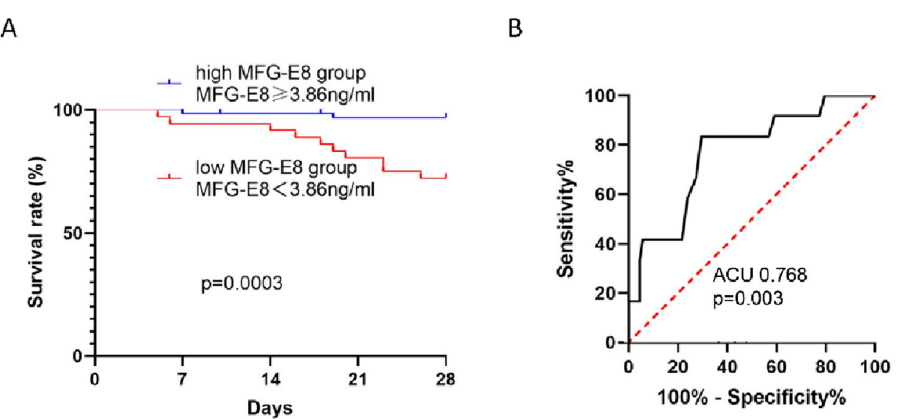
Figure 2. The ROC curves of predicting for 28-day survival and Kaplan–Meier estimator analysis of MFG-E8 for 28 day survival. ( A ) Kaplan–Meier estimator analysis of MFG-E8 for 28-day survival. The cut off value of MFG-E8 for the estimated 28-day mortality of patients with sepsis was 3.86 ng/mL. ( B ) The ROC curves of MFG-E8 for the predicting 28-day mortality in patients with